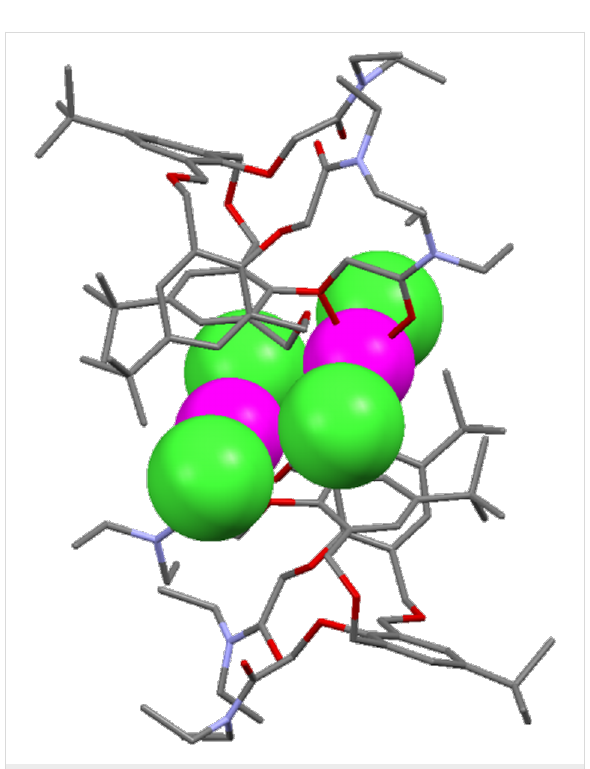
Figure 23: X-ray crystal structure of [ 17a ·HgCl 2 ] 2 (CCDC ID 168653) [69].